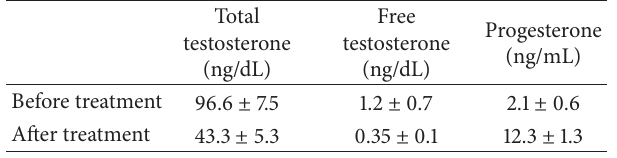
Table 1: Hormonal data before and after treatment with myoinosi- tol.